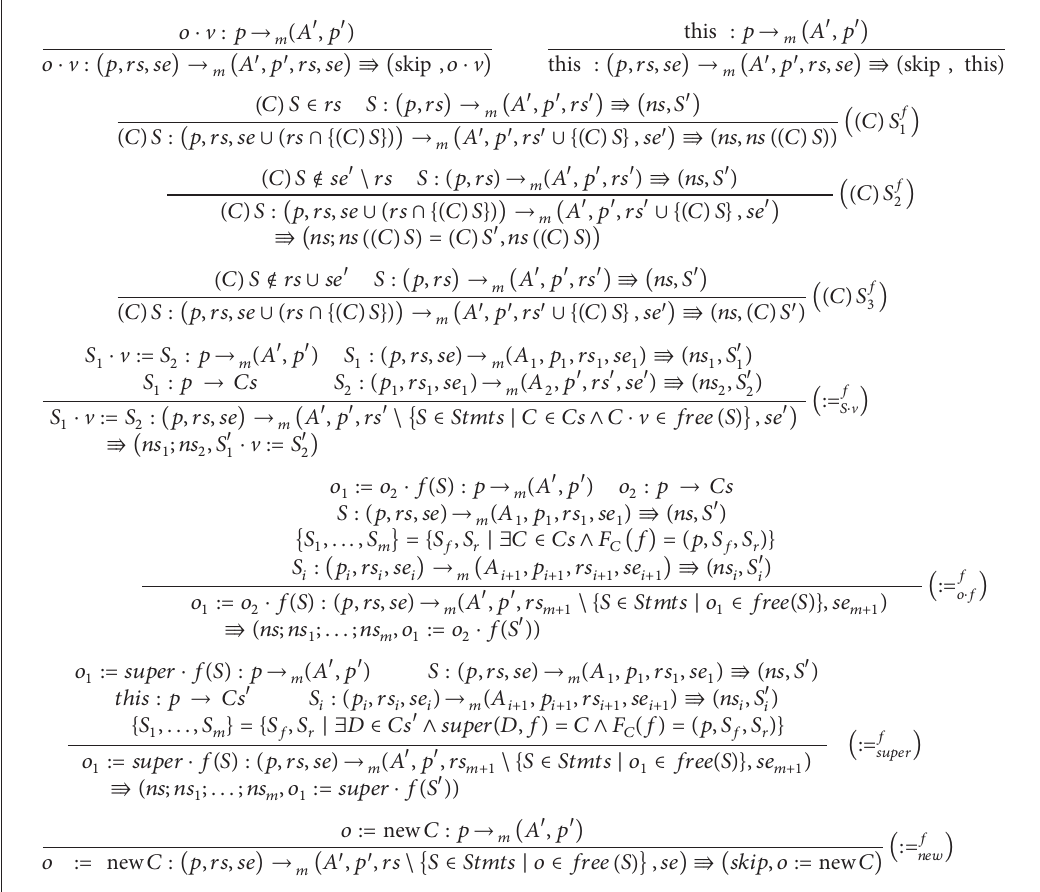
Algorithm 7: An extension for the frequent statements and de-references elimination type